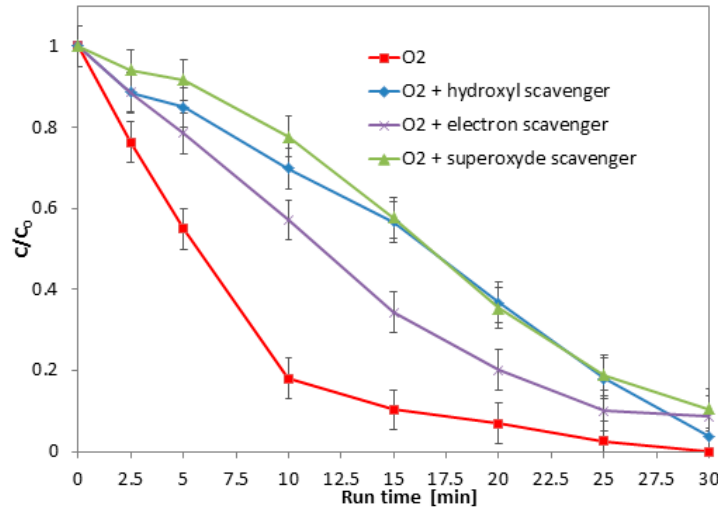
Figure 9. Influence of ROS on AO7 degradation in a DBD reactor in the presence of SF (glass spheres) without catalyst. AO7 initial concentration: 20 mg/L. Applied voltage: 12 kV. O 2 flow rate: 0.18 NL/min.